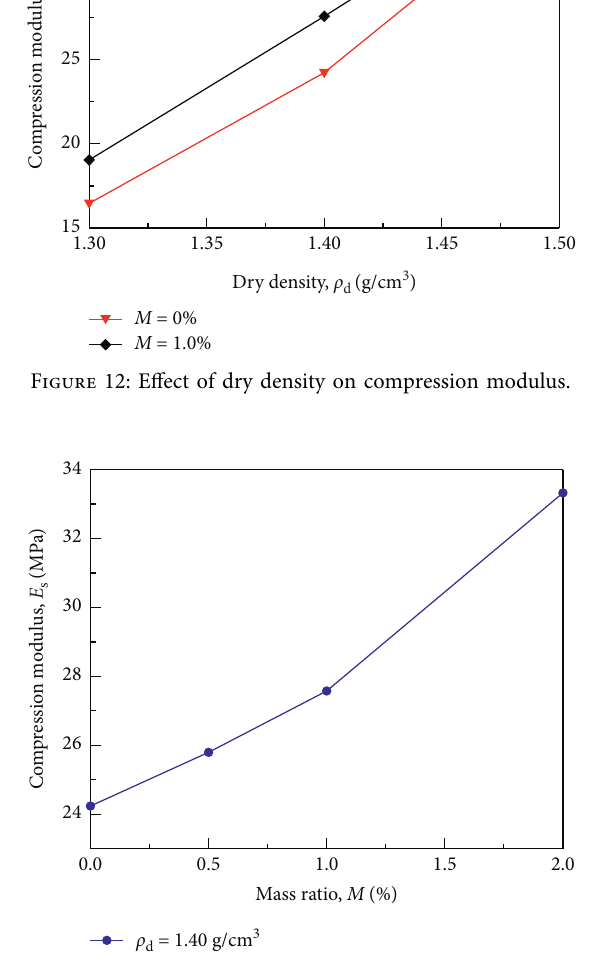
Figure 13: Effect of mass ratio on compression